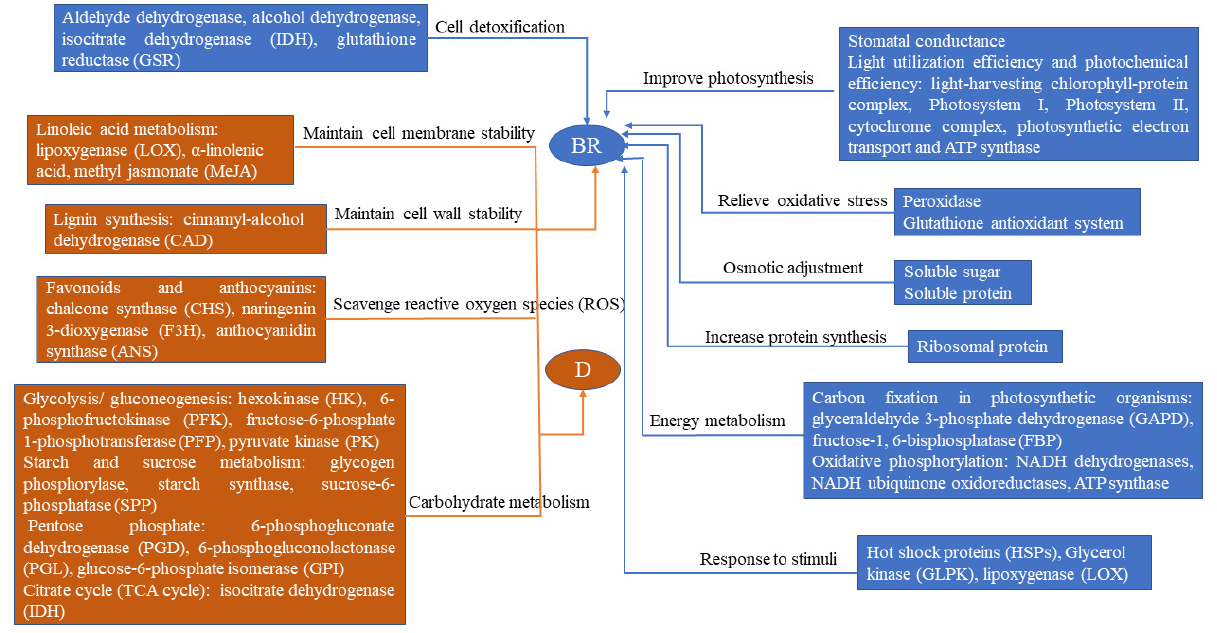
Figure 8. Model of BR regulating the response of Rhododendron delavayi to drought. Supplementary Materials: The following are available online at https://www.mdpi.com/article/10.3390/horticulturae7110501/s1, Table S1: The total proteins that were identified by DIA, Table S2: All information of differentially expressed proteins (DEPs) identified between groups, Table S3: The differentially expressed proteins (DEPs) involved in ribosome with significant change in abundance at 8 and 18 days of drought (D) and BR pre-treatment (BR), Table S4: The differentially expressed proteins (DEPs) involved in energy metabolism with significant change in abundance at 8 and 18 days of drought (D) and BR treatment (BR), Table S5: The differentially expressed proteins (DEPs) involved in carbohydrate metabolism with significant change in abundance at 8 and 18 days of drought (D) and BR treatment (BR), Table S6: The differentially expressed proteins (DEPs) involved in cell detoxification with significant change in abundance at 8 and 18 days of drought (D) and BR treatment (BR), Table S7: The differentially expressed proteins (DEPs) involved in lipid metabolism with significant change in abundance at 8 and 18 days of drought (D) and BR treatment (BR), Table S8: The differentially expressed proteins (DEPs) involved in biosynthesis of secondary metabolites and other secondary metabolites with significant change in abundance at 8 and 18 days of drought (D) and BR treatment